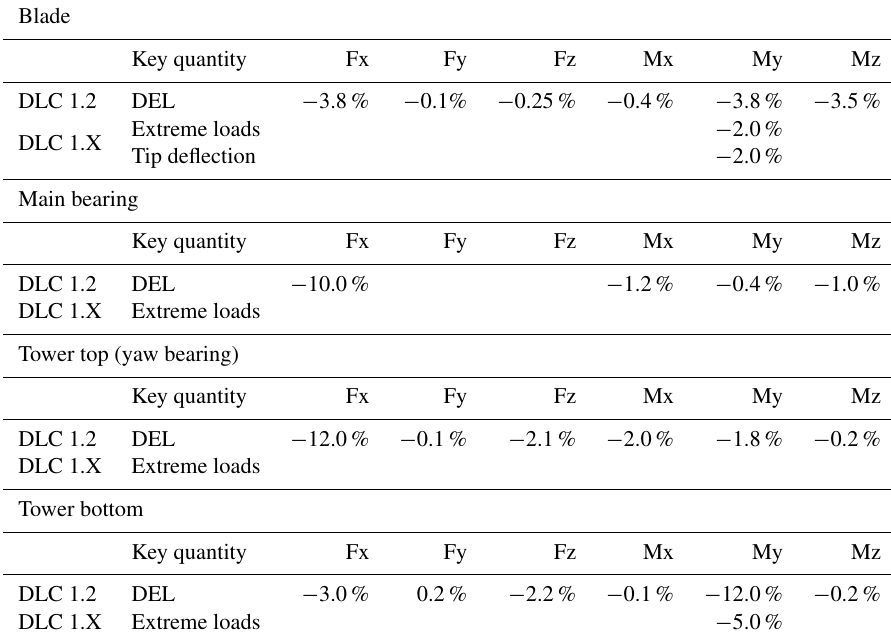
Table 2. Load-reduction coefficients based on Bossanyi et al. (2014), expressed as percentages with respect to a non-LAC controller. Blade Key